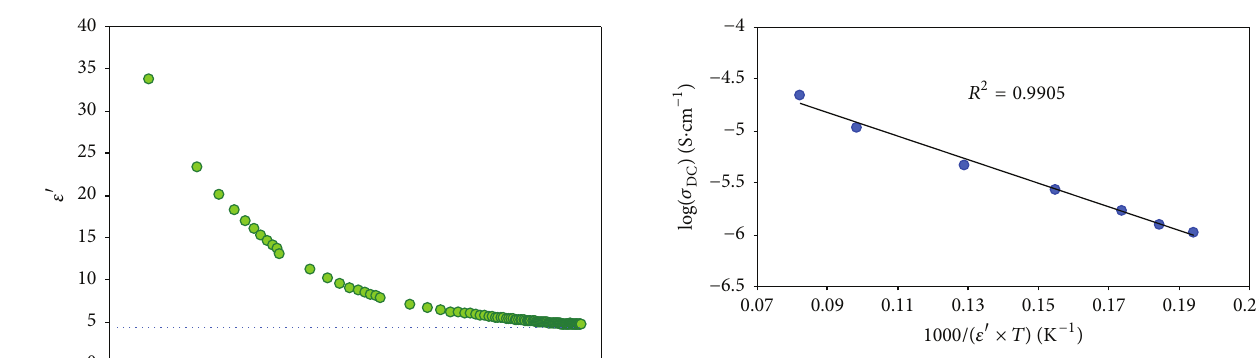
Figure 15: Temperature dependence of DC conductivity (reformu- lated Arrhenius equation) for CSNC2 system.